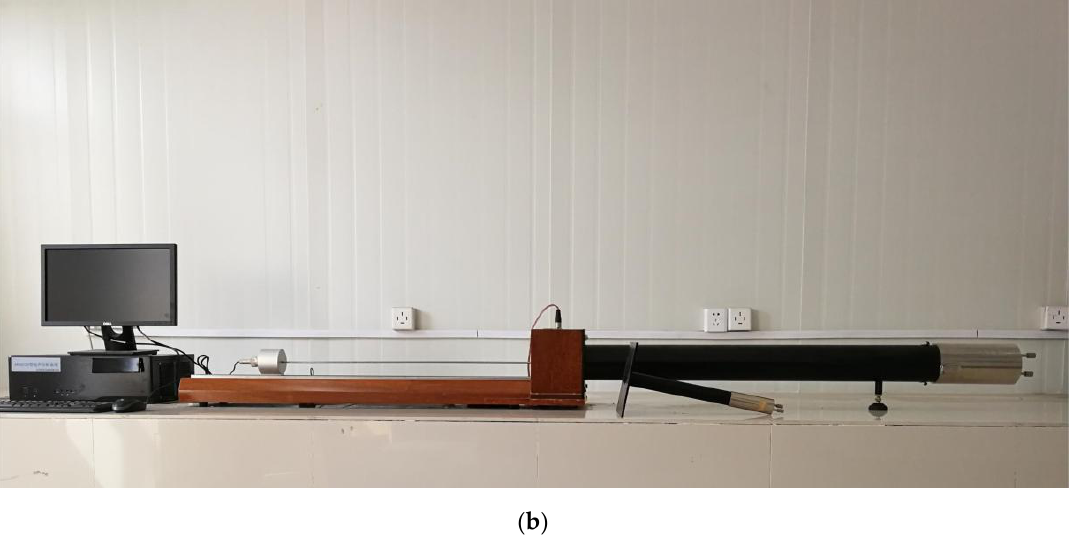
Figure 7. The AWA6128A detector for the standing wave tube measurement. ( a ) Schematic diagram; ( b ) actual picture.